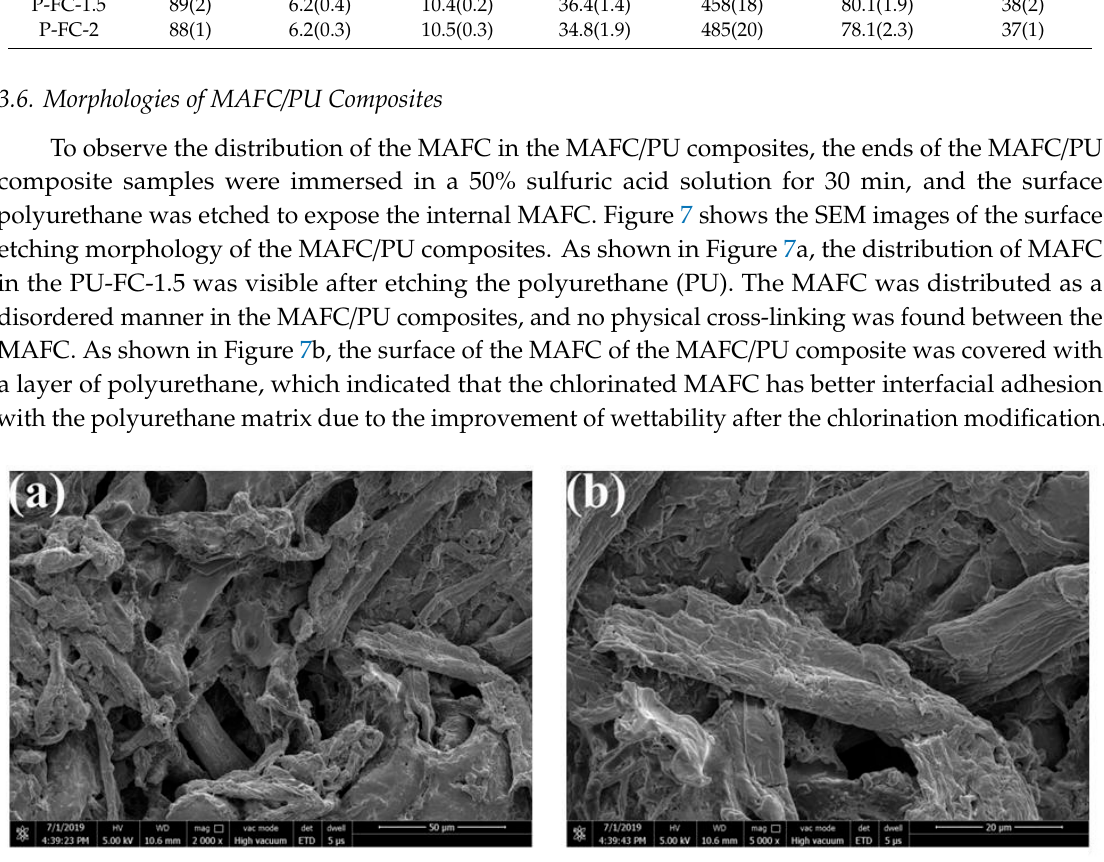
Table 4. Variations in mechanical properties of polyurethane composites with the increasing modified meta-aramid fibrids content.